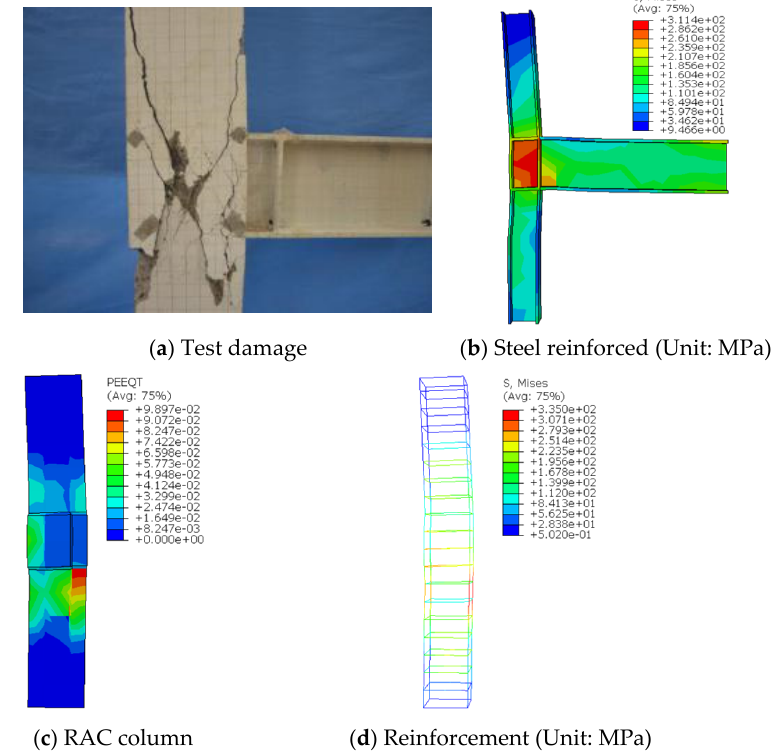
Figure 16. Comparison of test and simulation results of CFJ7.